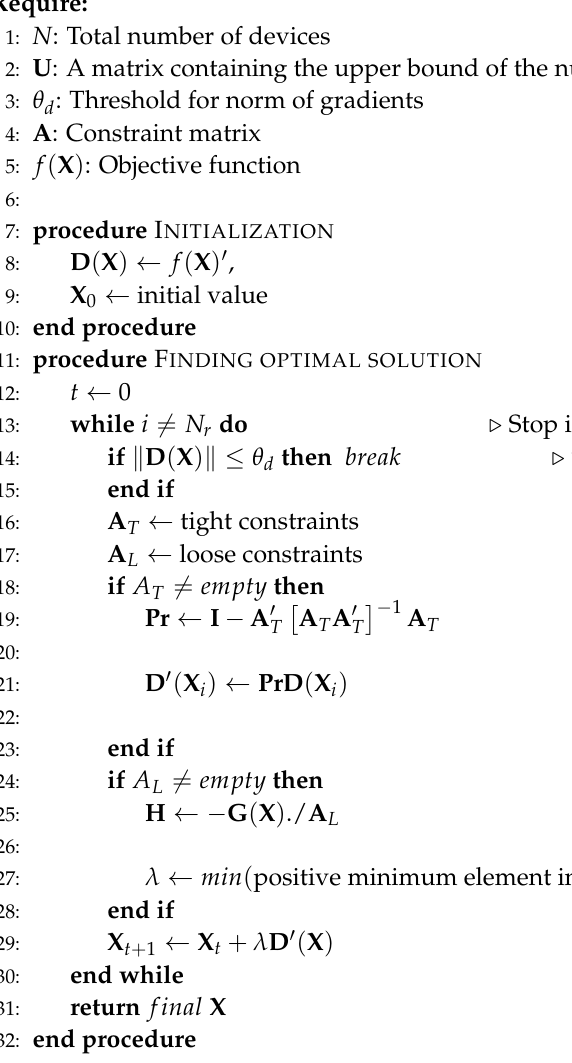
Algorithm 1 Gradient Projection Method to find an optimal distribution of SF